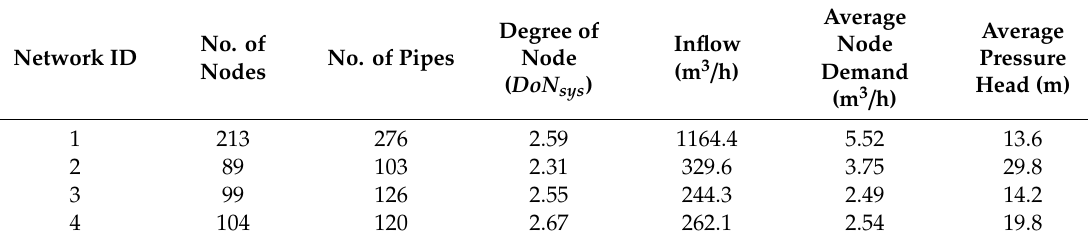
Table 1. Network